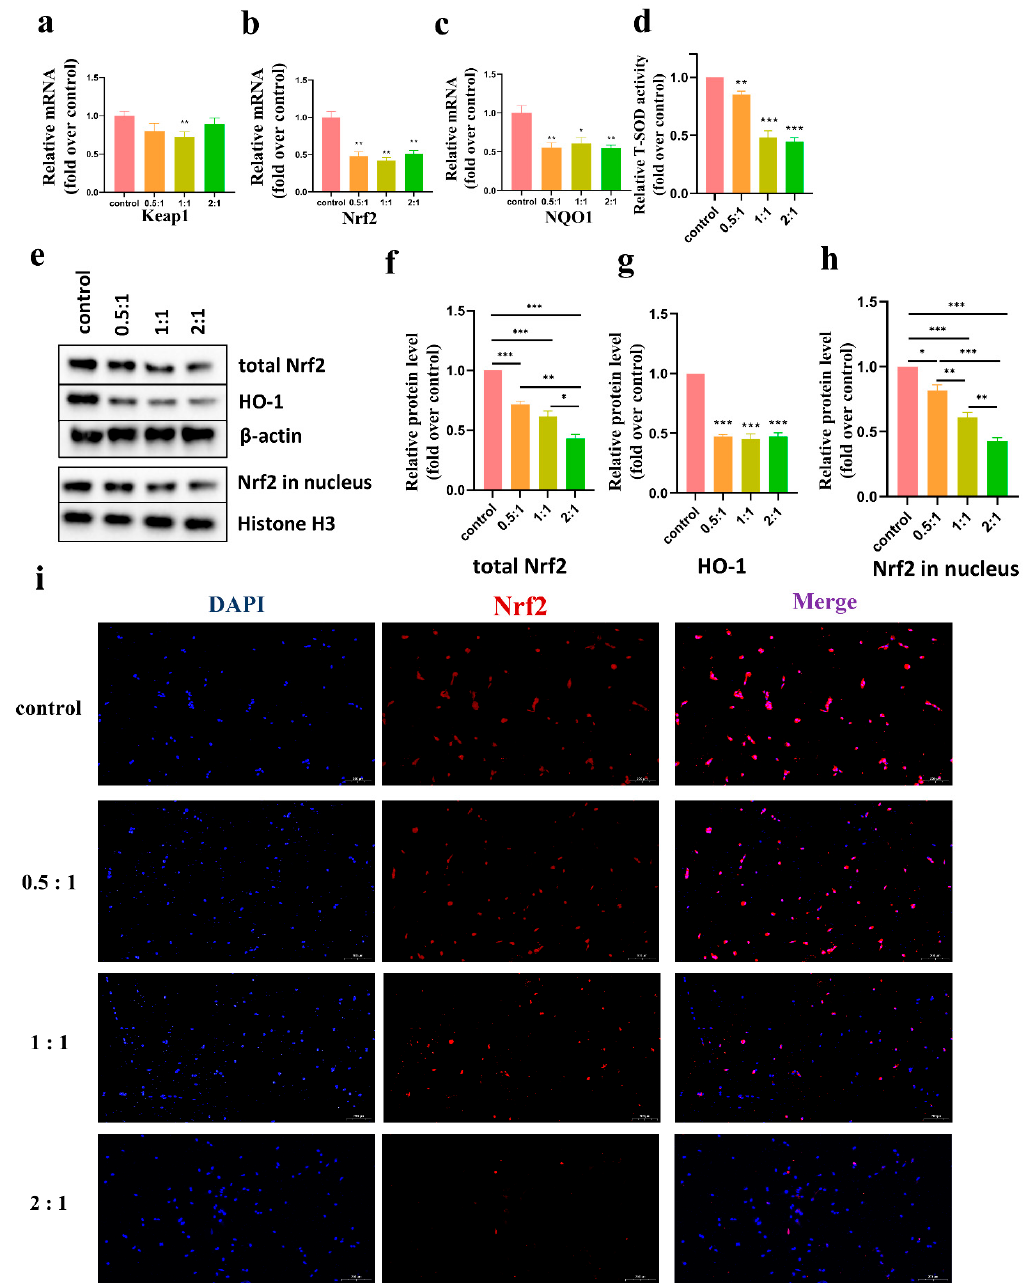
Figure 5. AD-MSCs inhibited the expression of Nrf2 and antioxidant enzymes. ( a – c ) The mRNA expression of KEAP1, Nrf2, and NQO1 in HSFs assessed after 48 h of coculturing was determined through RT-PCR. The graph represents the expression of Keap1, Nrf2, and NQO1 relative to that of GAPDH (n = 3). ( d ) T-SOD activity of HSFs was assessed after 48 h of coculturing, and the developed color was measured at 550 nm (n = 4). ( e – h ) Western blot assay for total Nrf2, HO-1, and Nrf2 in the nucleus after 48 h in HSFs of different groups (n = 3). ( i ) Immunofluorescence staining used to determine the expression levels of Nrf2 in HSFs of different groups after 48 h of coculturing, scale bar = 200 µ m. * p < 0.05, ** p < 0.01, and *** p < 0.001 vs.